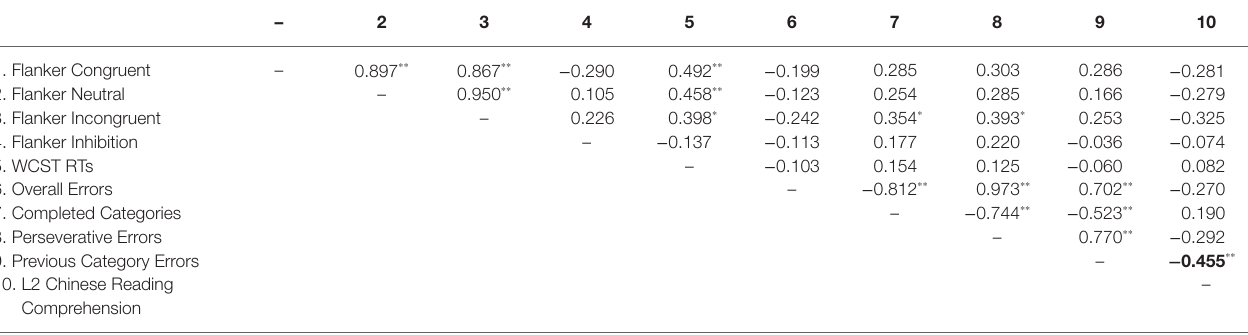
TABLE 5 | Pearson Correlations between cognitive control and L2 Chinese reading comprehension.